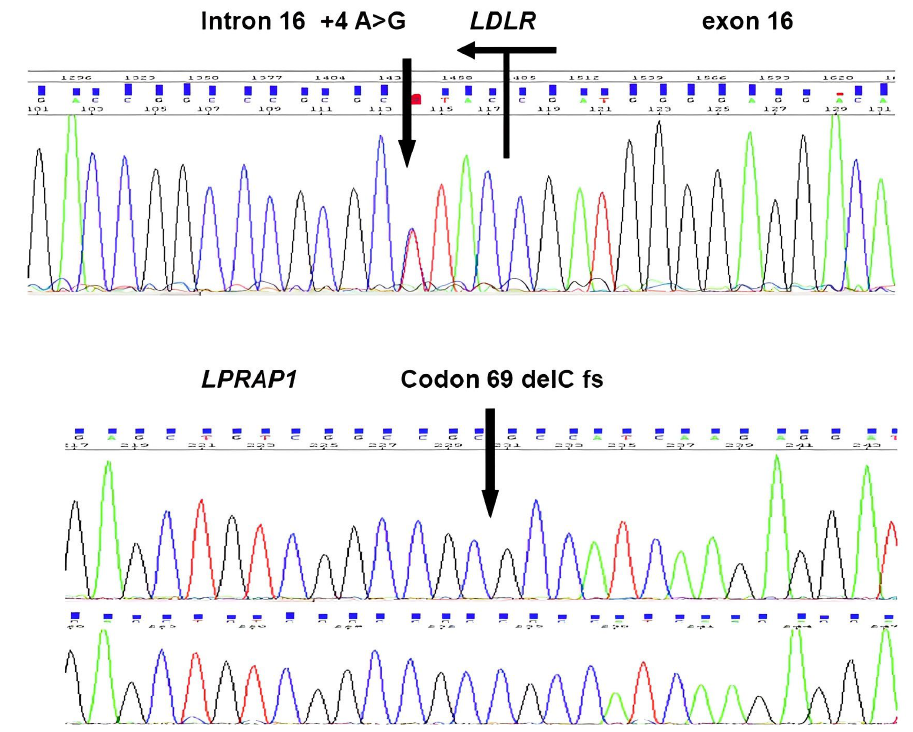
Figure 1. Sanger sequencing of one of the multiple carriers of LDLR , c .2389+4A>G, and the homozy- gous carrier of LDLRAP1: c.207delC variant. For the LDLR , we show the reverse strand sequence with the exon 16-intron 16 site.